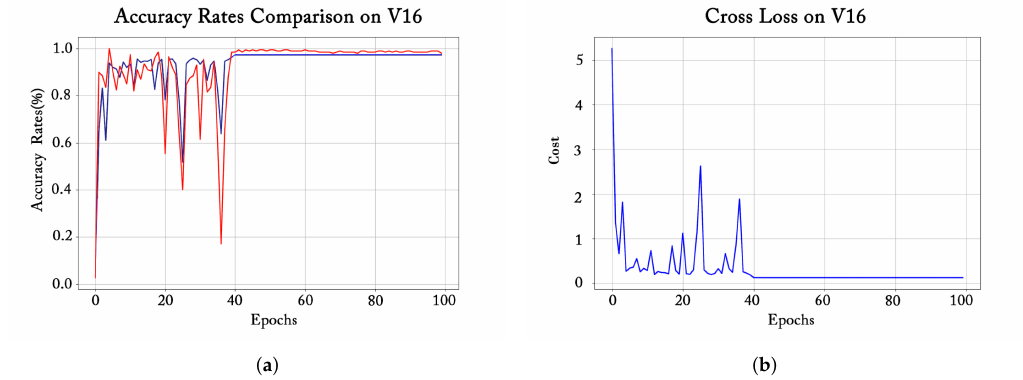
Figure 10. Training accuracy, validation accuracy, and training loss during V16 model training. ( a ) Accuracy comparison. ( b ) Cross